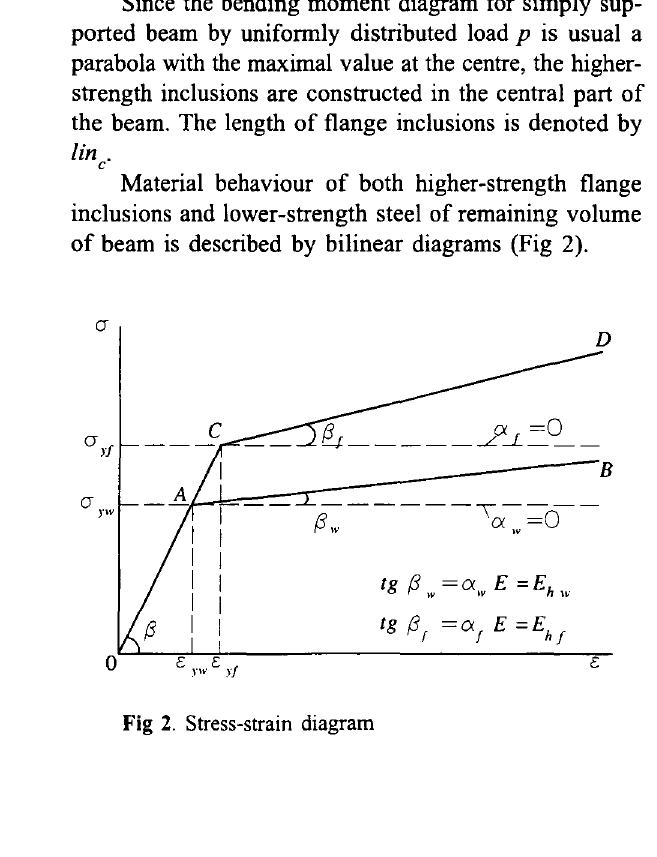
Fig 2. Stress-strain